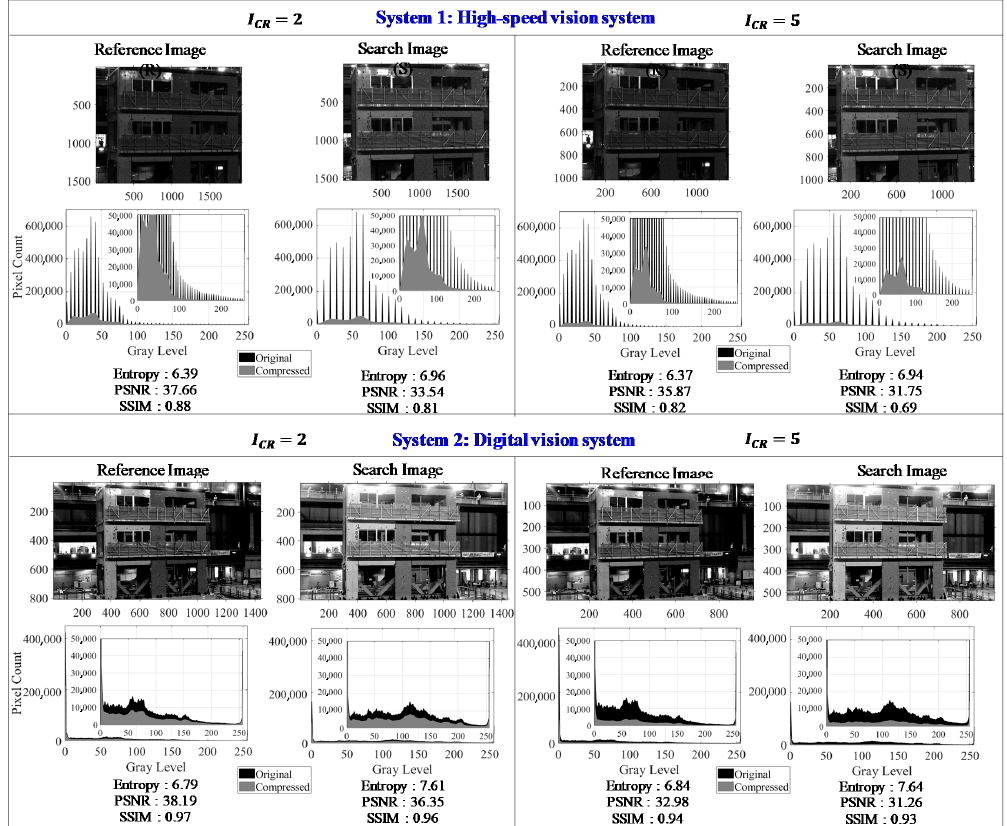
Figure 15. Image quality assessment from compressed images using bicubic interpolation measured by two-vision-based systems, i.e., high-speed vision system and digital cameras